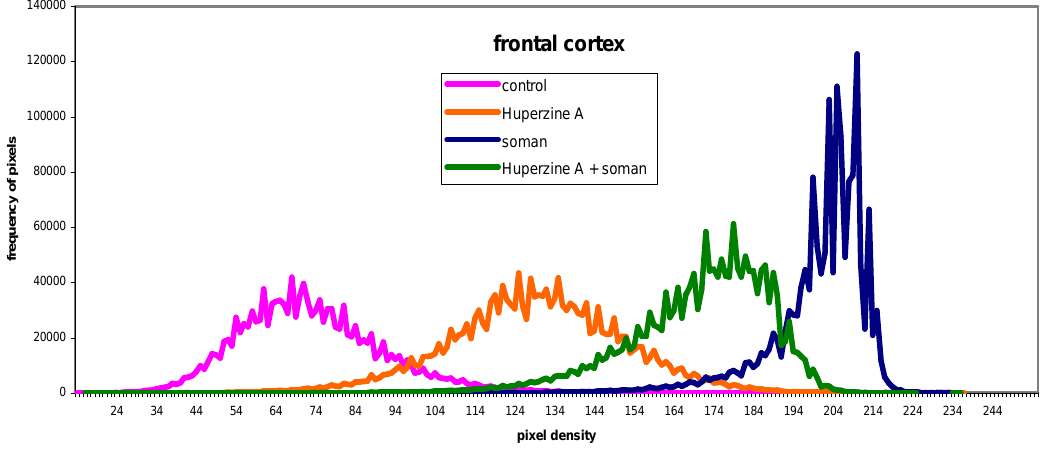
Bottom: Quantitative evaluation of histochemical data: Density curves of microphotographs. frontal